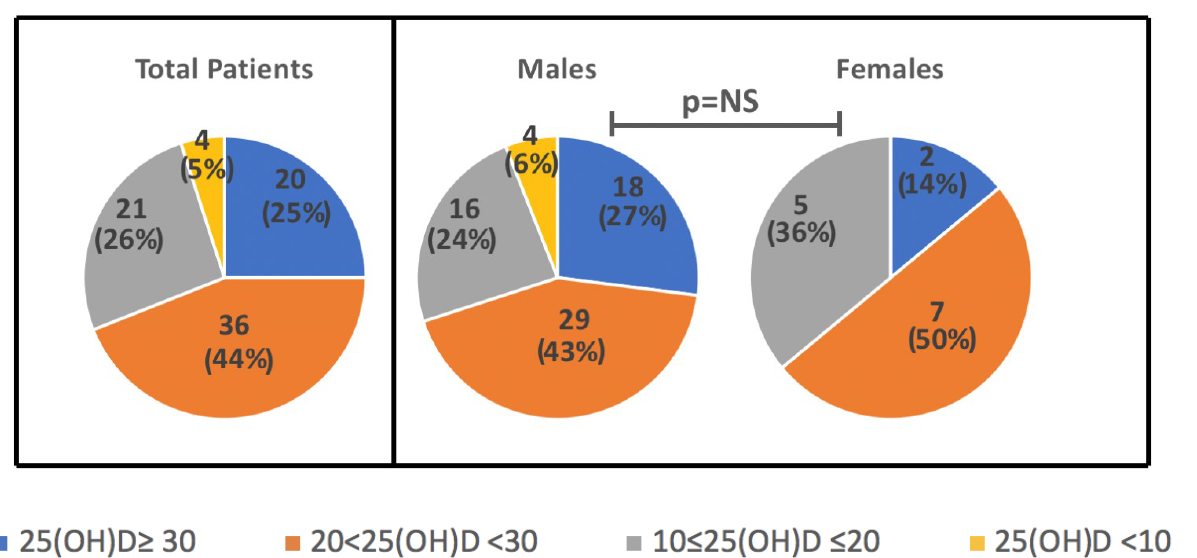
Figure 1. Distribution of 25(OH)D ranges in total sample and in the subgroups of M and F children (ranges: adequate levels ≥ 30, insufficient 21 – 29, deficient <20 ng/mL with severe deficiency for values <10 ng/mL). Data are N (%).